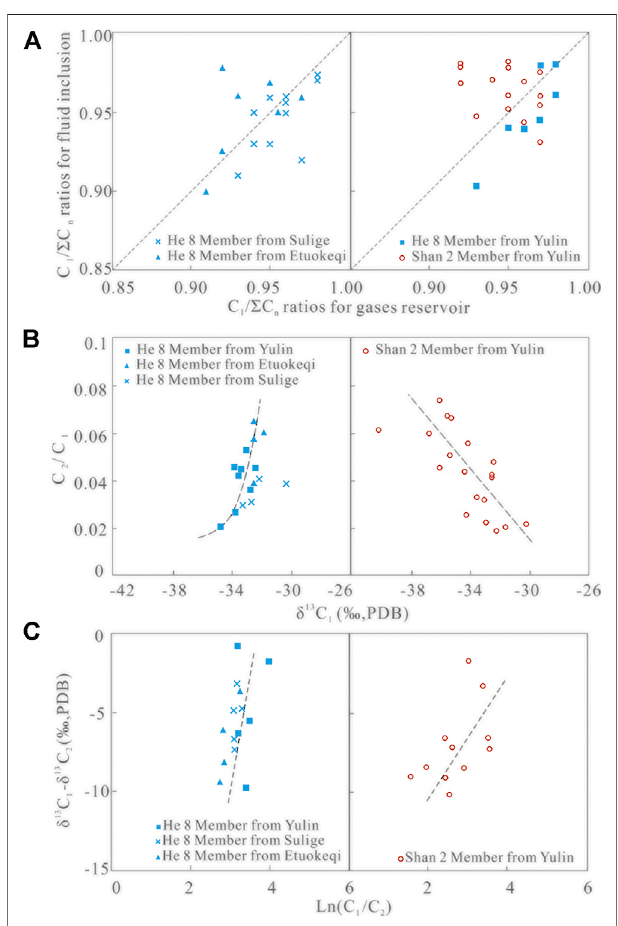
FIGURE 3 | Plot of geochemical features between gaseous inclusions and gas